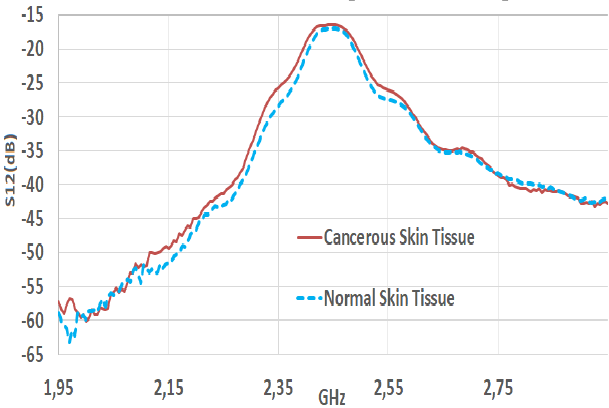
Figure 8: Differences of S 12 values between cancerous and normal tissue obtained from the experimental setup